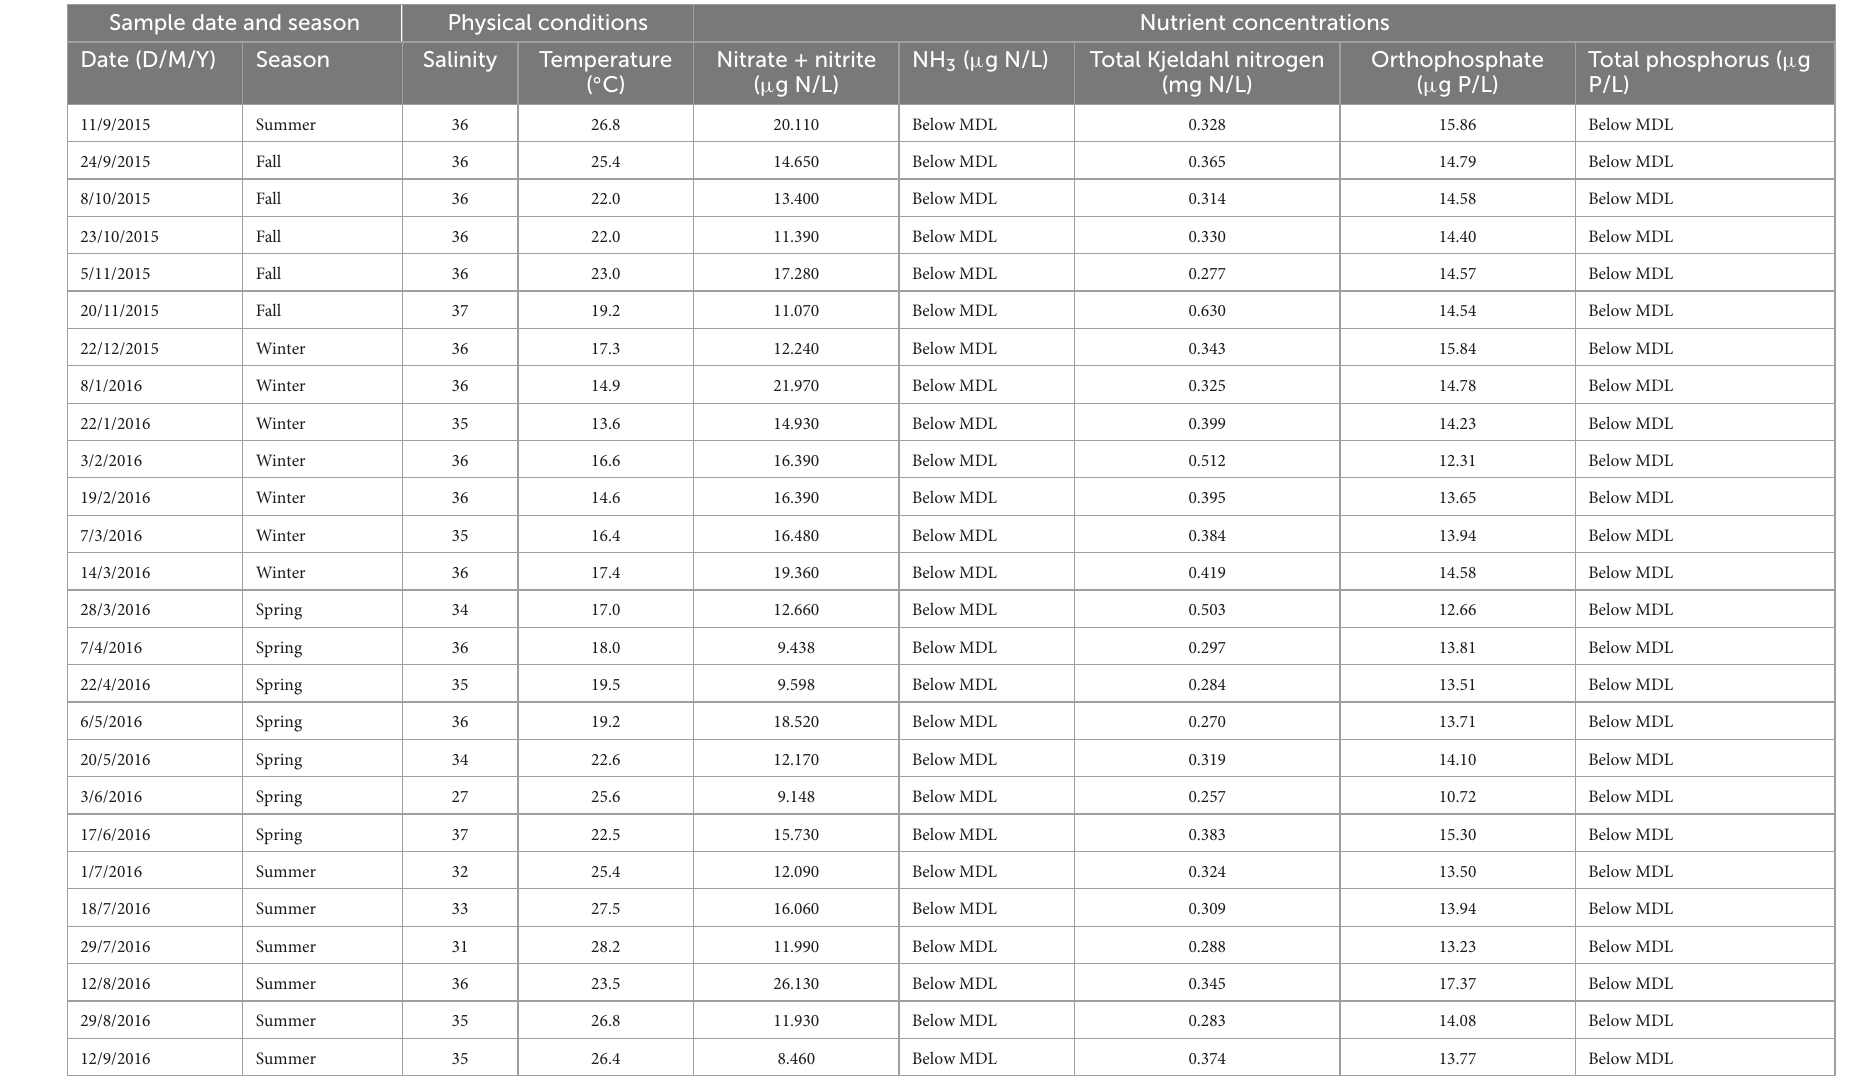
TABLE 1 Environmental parameters for each